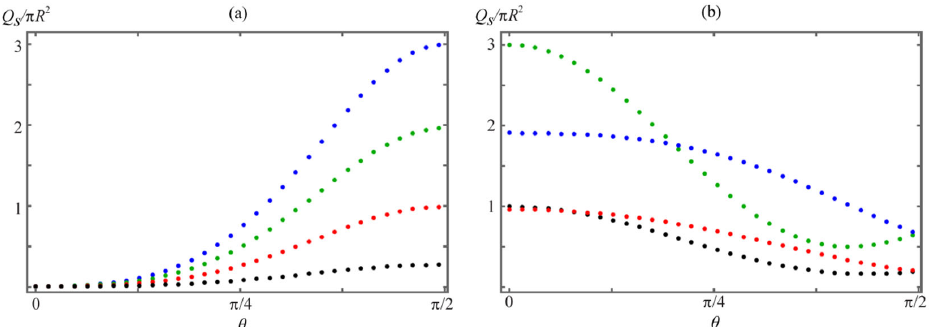
polarizations. Figure 3 is an exact match with the results obtained in Figure 2 of Ref. [43] and Figures 2 and 3 of Ref. [45].